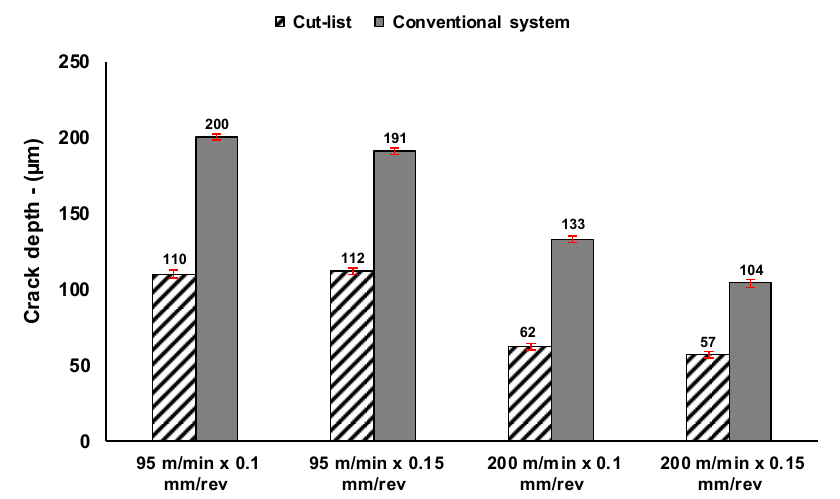
Figure 15. Measured crack depth for different chips under various cutting conditions.